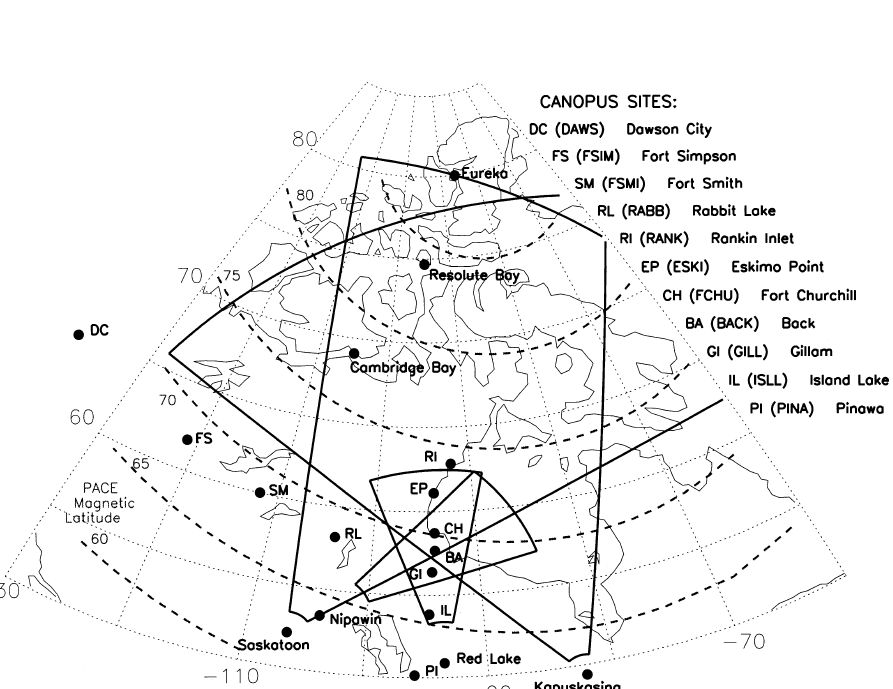
Fig. 1. Schematic representation of the solar wind-magnetosphere-ionosphere cou- pling and generation of polar patches. Several phenomena and causal relation- ships that are portrayed in this figure are supported by the data presented in the case study (December 2, 1993): the interplane- tary magnetic field ( IMF ) and solar wind Alfve´ n waves (Fig. 3), ionospheric cleft ( DPY ) currents (Fig. 5), field line reso- nances ( FLRs ) (Figs. 6, 8, 12, and 13), field aligned currents ( FACs ) and the iono- spheric structure equatorward of the cusp footprint (Figs. 7, 8, 9, and 10), pulsed magnetic reconnection (flux transfer events, FTEs ) at the subsolar magnetopause, flow channel events ( FCEs ) and polar patch formation near the cusp footprint (Figs. 8 and 16), polar cap convection (Fig. 15), and patches convecting in the polar cap (Figs. 14, 17, 18, and 19)